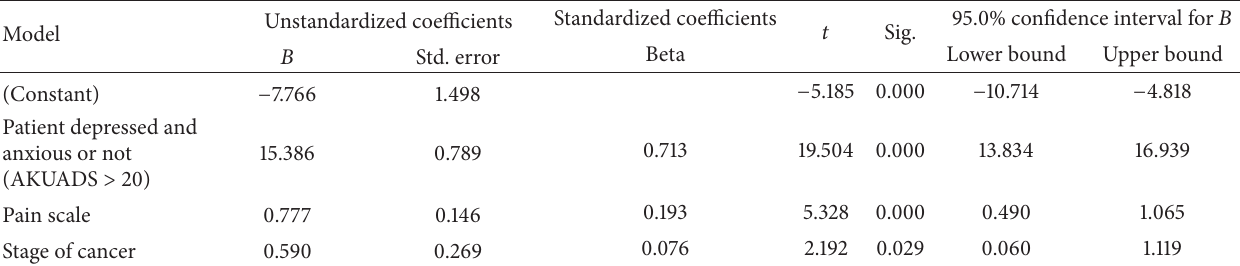
Table 4: Multiple linear regression analysis of AKUADS scale as a dependent variable against independent